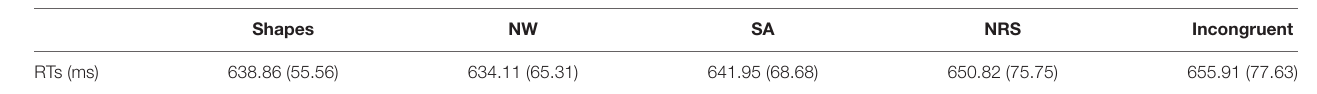
TABLE 1 | Mean response latencies (ms) per